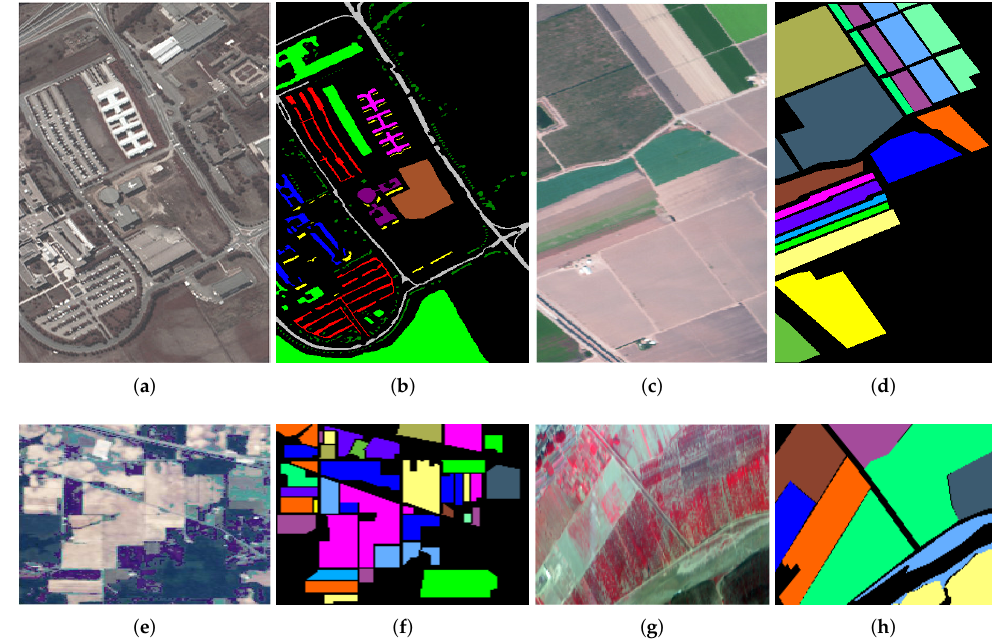
Figure 6. Reference maps of the four HSIs. In this figure, sub-maps ( a , c , e , g ) refer to the false-color images of the UP, SV, IN, and ZY, whereas sub-maps ( b , d , f , h ) refer to the ground truth corresponding to